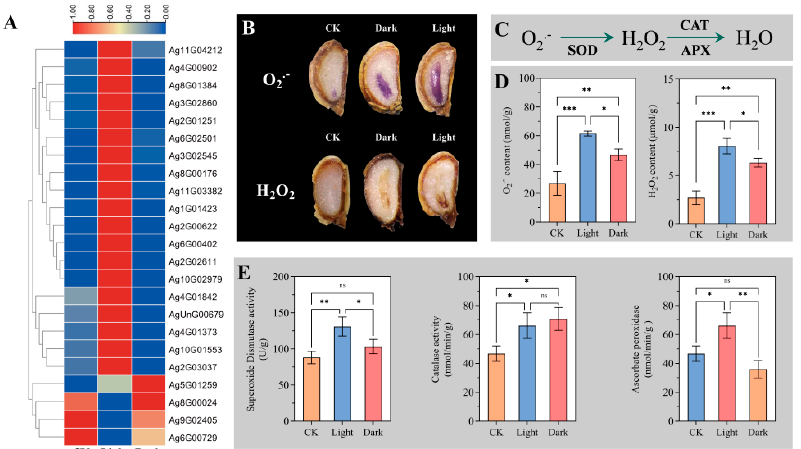
Figure 7. Non-enzymatic mechanisms of endosperm weakening. ( A ) Expression of extension protein genes under different conditions. ( B ) Histochemical staining of O 2 · – and H 2 O 2 . ( C ) Brief steps for reactive oxygen species scavenging. ( D ) Content of O 2 · – and H 2 O 2 under different conditions. ( E ) SOD, CAT, APX enzymatic activity. The transcripts of DEGs were normalized as 0–1. Gene IDs are showed by the legend on the right. Expression levels ranging from red to blue indicate high to low expression for genes, respectively. * p < 0.05, ** p < 0.01, *** p < 0.001, “Tukey’s” test. ns represents no difference. Vertical bars indicate means ± SD ( n = 3).